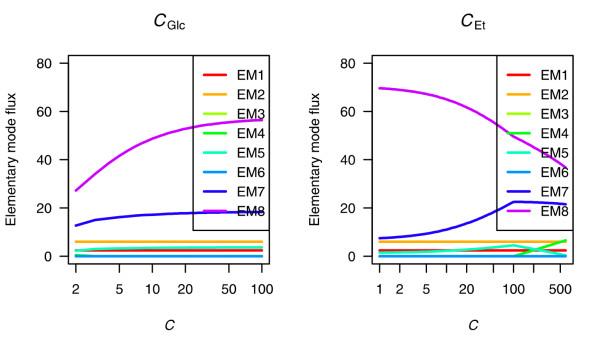
Effects of external concentrations on elementary mode fluxes. Effects of external concentrations of glucose (left) and ethanol (right) on elementary mode fluxes. In both cases, the non-variable concentration was 50, and all kinetic parameters were kept at their reference values given in Table 2. Horizontal axes use logarithmic scales.